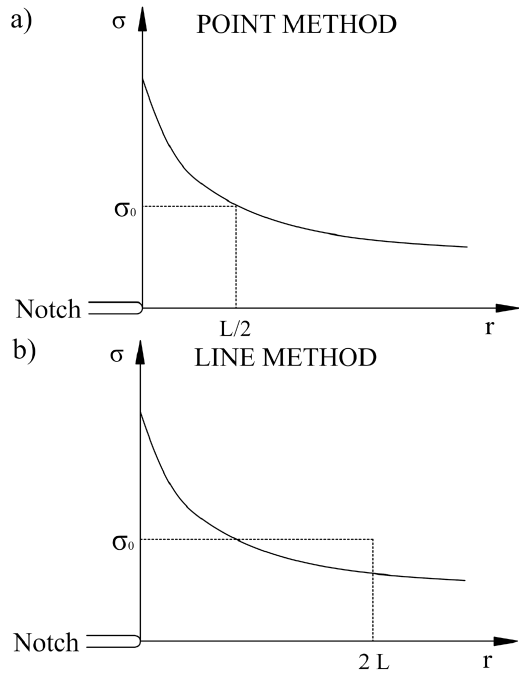
Figure 2. Graphical representation of the working principles of (a) PM and (b)